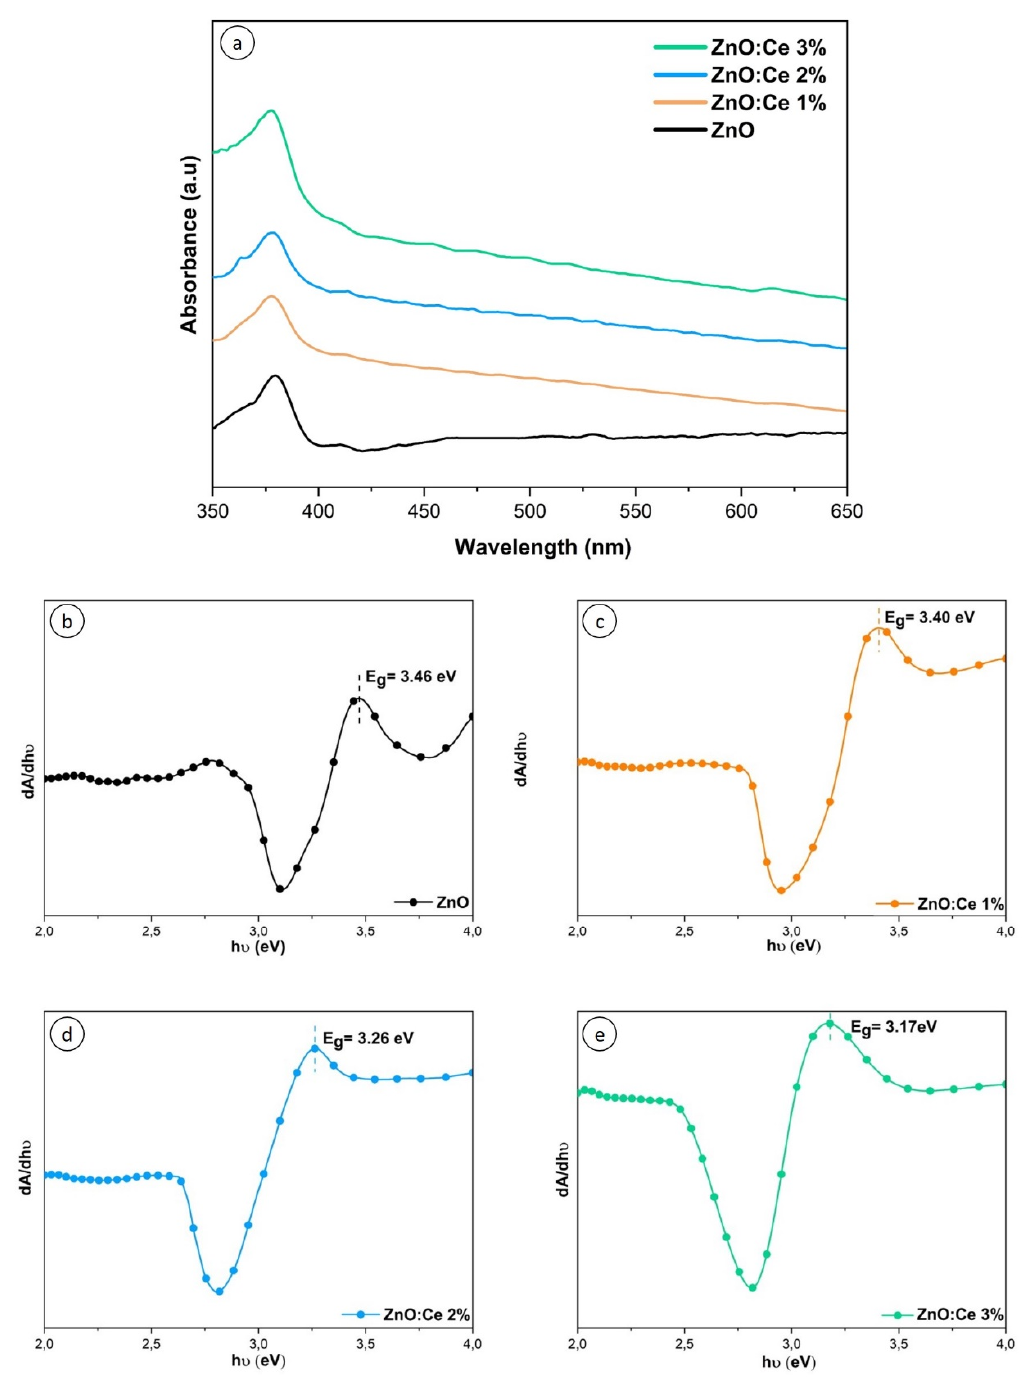
Figure 10. ( a ) UV–Vis absorption spectra of the ZnO and ZnO:Ce photocatalysts. ( b – e ) Plots of the first derivative of the optical absorbance with respect to the photon energy of the Ce-modified ZnO photocatalysts. Table 2. The dependence of the band gap and exciton energy on the Ce content.